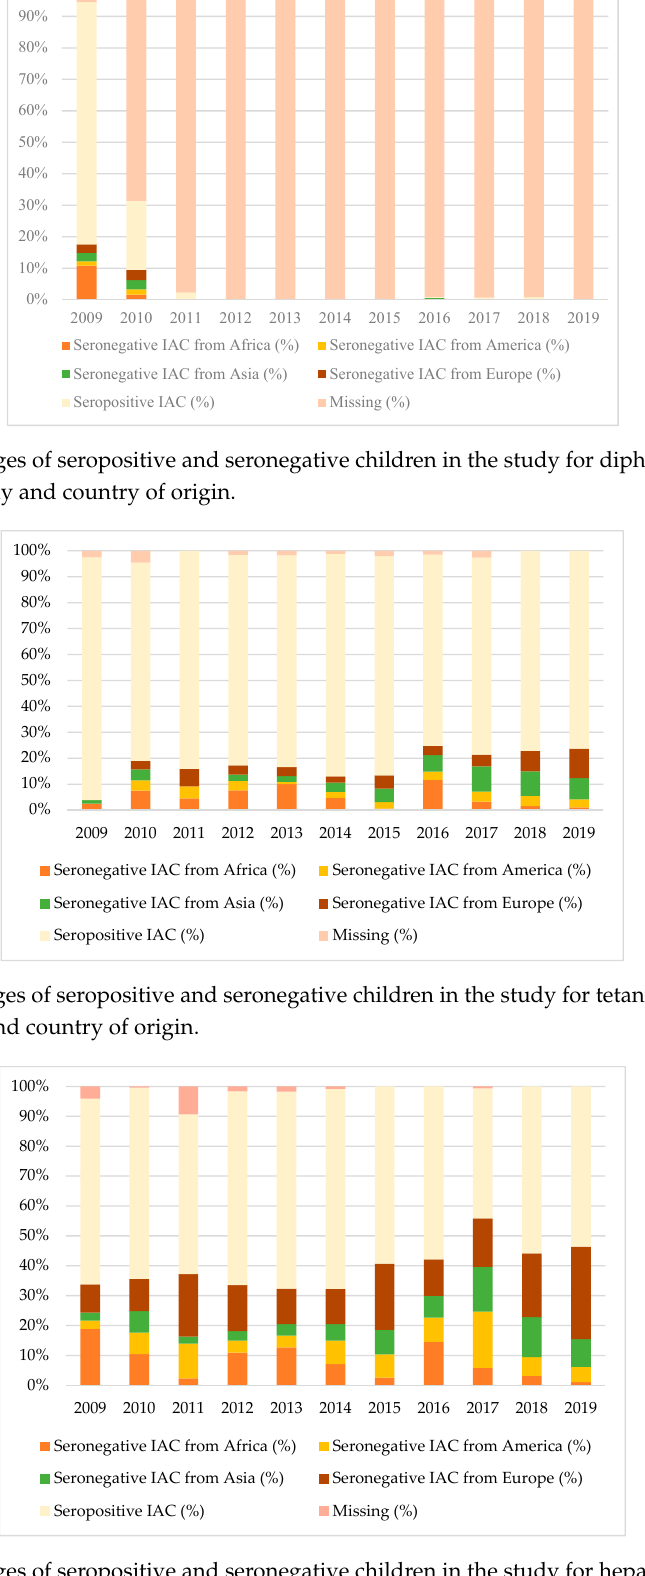
Figure 3. Percentages of seropositive and seronegative children in the study for hepatitis B, by year of the first visit in Italy and country of origin .